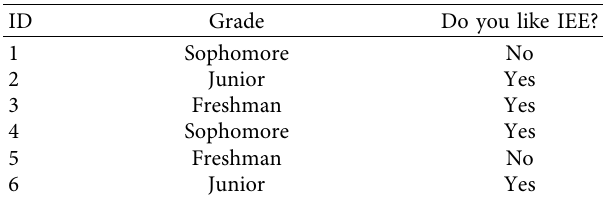
Table 6: Grade attribute list.